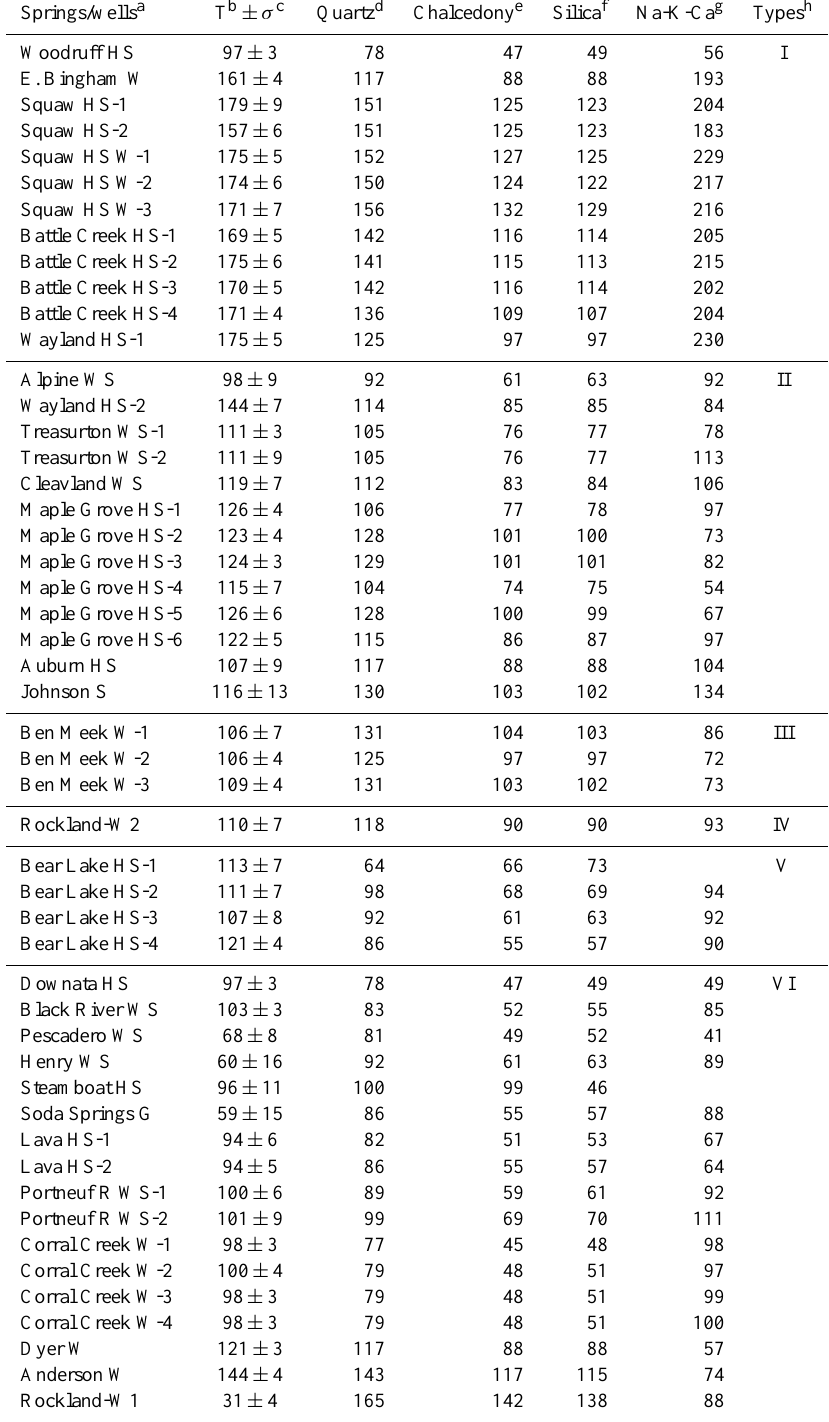
Table 3. Temperature ( ◦ C) estimates for southeastern Idaho thermal waters RTEst and other geothermometers. Springs/wells a